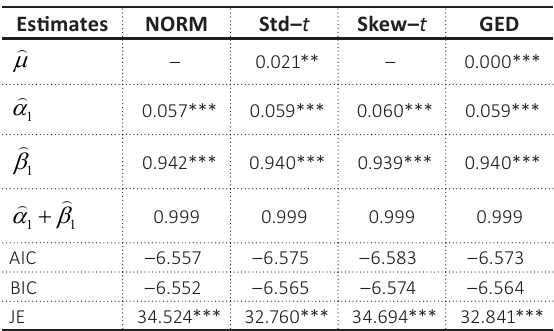
Table 3. ML parameter estimates of the GARCH (1, 1) for different innovation distributions